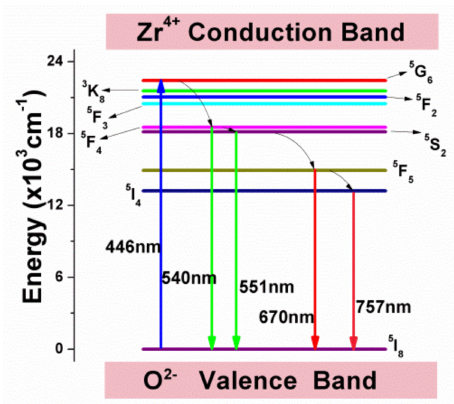
concentrations higher than 0.30 mol%, the emission peak at 551 nm ( 5 S 2 → 5 I 8 ) was higher than that at 540 nm ( 5 F 4 → 5 I 8 ).